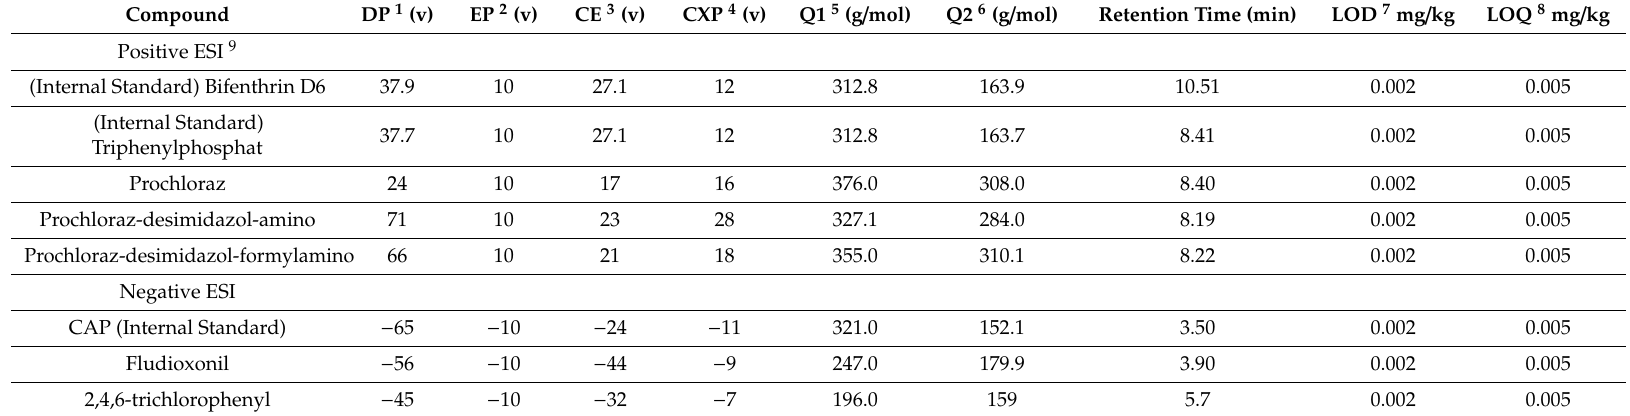
Table 1. Multiple reaction monitoring (MRM) transition and optimized parameters for pesticides analyzed by LC-MS /